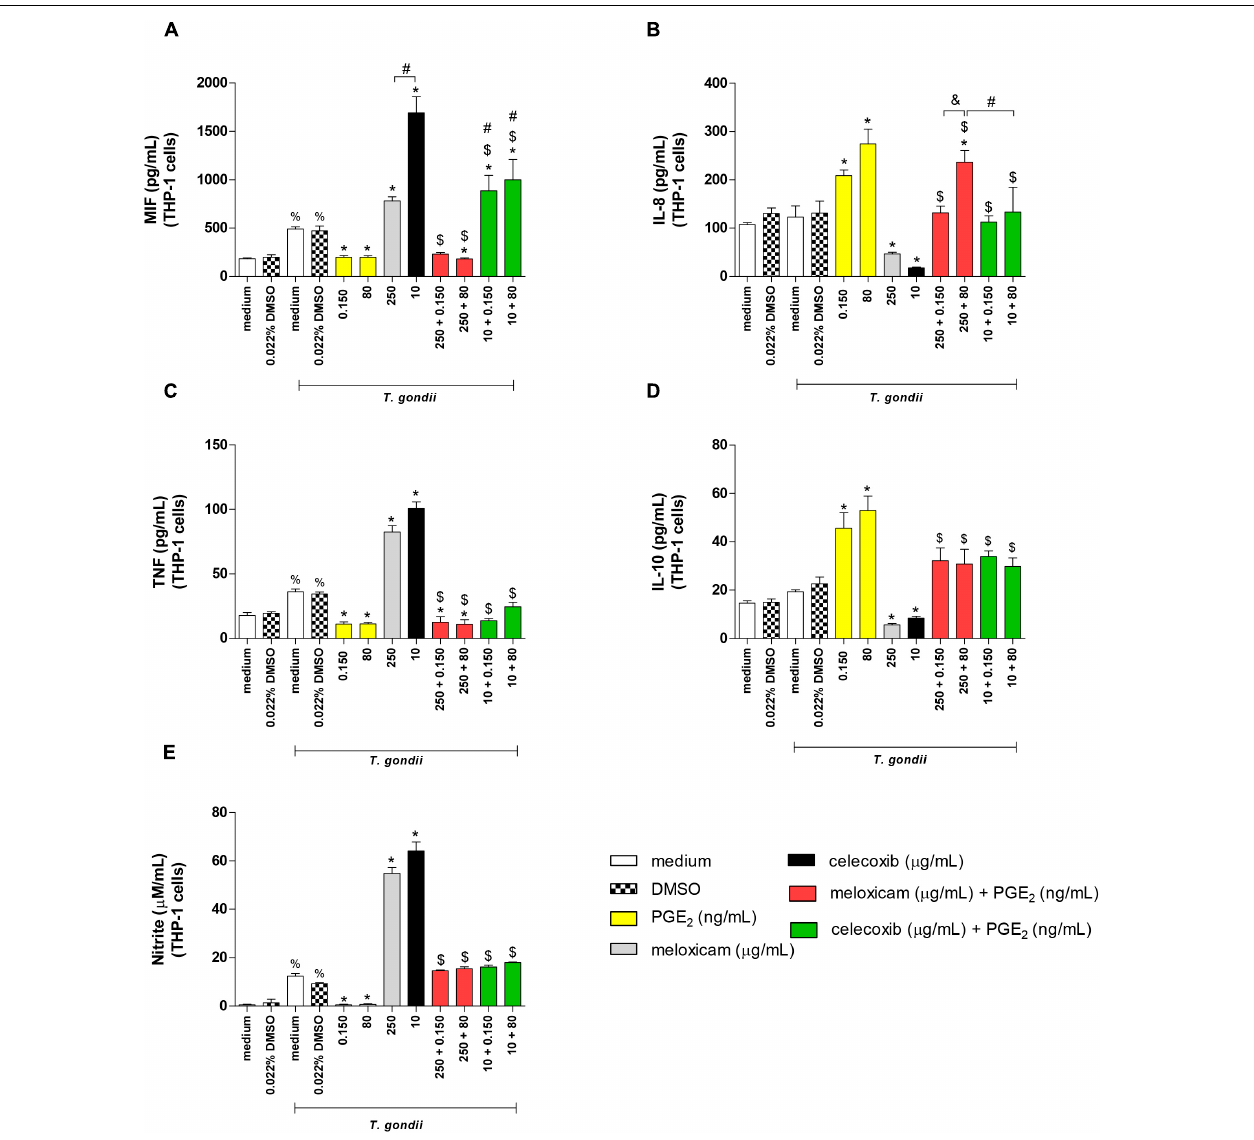
FIGURE 7 | Cytokine and nitrite production in infected THP-1 cells treated with COX-2 inhibitors and/or PGE 2 . THP-1 cells were seeded in 96-well plates (3 × 10 4 cells/200 µ L) for 24 h, infected with T. gondii tachyzoites (2F1 clone, RH strain), and treated or untreated with meloxicam or celecoxib in the presence or absence of PGE 2 for additional 24 h. The supernatants were collected for measurement of MIF (A) , IL-8 (B) , TNF (C) , and IL-10 (D) by sandwich ELISA, or nitrite (E) by the Griess method. DMSO (0.022%) was used to exclude any effect of DMSO in the cytokine or nitrite production. Data are shown as mean ± SEM from two independents experiments with eight replicates. Differences between groups were analyzed by two-way ANOVA with the Bonferroni post hoc test. Significant differences in relation to untreated/uninfected cells (medium) or uninfected/DMSO-treated cells ( % P < 0.05), between untreated/infected cells (medium) or infected/DMSO-treated cells ( ∗ P < 0.05), between different concentrations of COX-2 inhibitors in the absence or presence of PGE 2 ( # P < 0.05), between different concentrations of meloxicam plus PGE 2 ( & P < 0.05), and between COX-2 inhibitors plus PGE 2 and respective control (infected and meloxicam or celecoxib-treated cells) ( $ P <